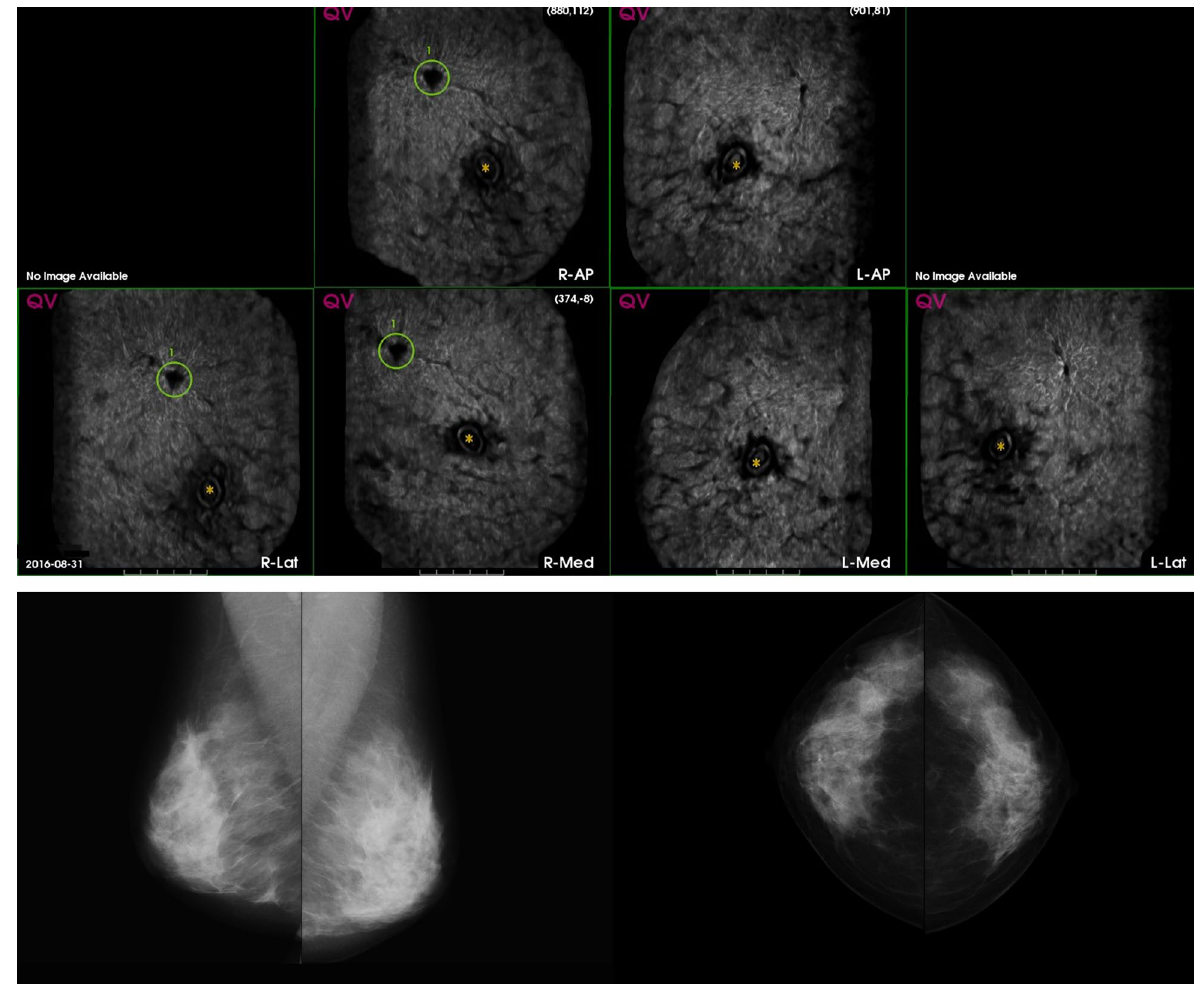
Fig. 3 ABUS (top) and DM (bottom) examination of a woman 44 years old with a diagnosed invasive ductal carcinoma 2 cm grade 3, right breast. AI‑ABUS detected the cancer lesion with a high score (99.9, scale 1–100), which was not detected by AI‑DM (score of 37.8, scale 1–100) or the radiologists (BI‑RADS 2 and BI‑RADS 3,